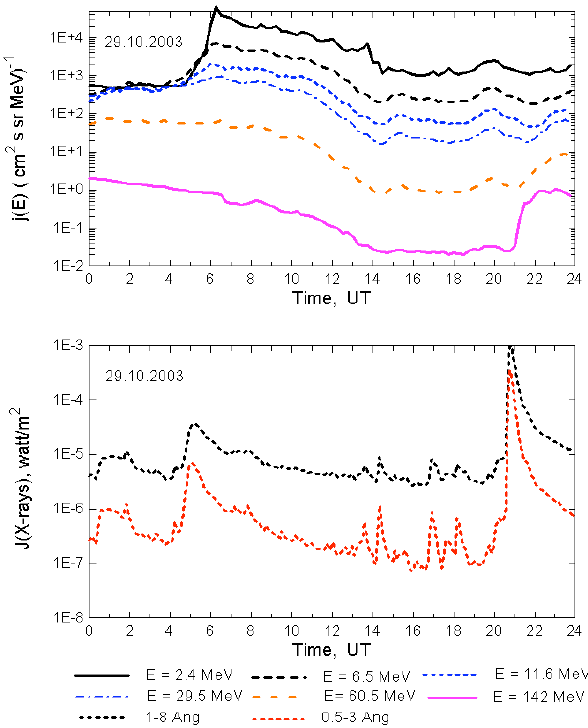
Fig. 3 . Differential solar proton fluxes and hard solar X-rays inten- sity observed on 29 October 2003.